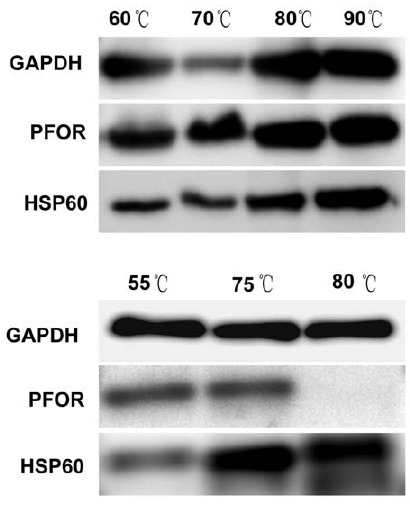
Figure 7. The expression pattern of temperature-dependent proteins in T.maritima and T.tengcongensis . The upper panel is the proteins from T.maritima and the lower panel is the proteins from T. tengcongensis